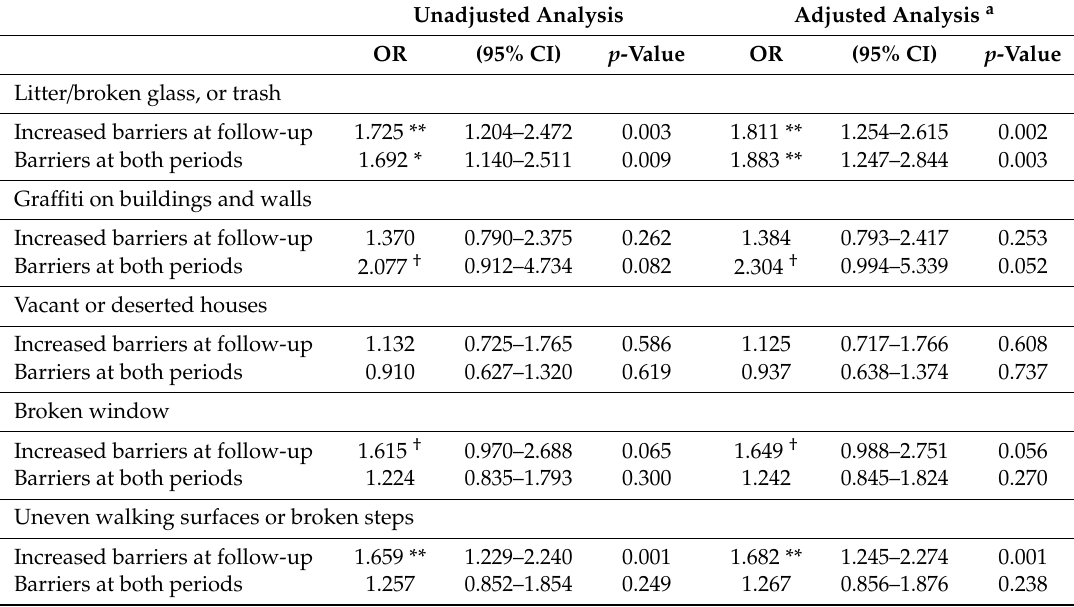
Table 2. Environmental predictors of recent falls at the 1-year follow-up in individuals without a history of falls: unadjusted analysis and partially adjusted analyses.